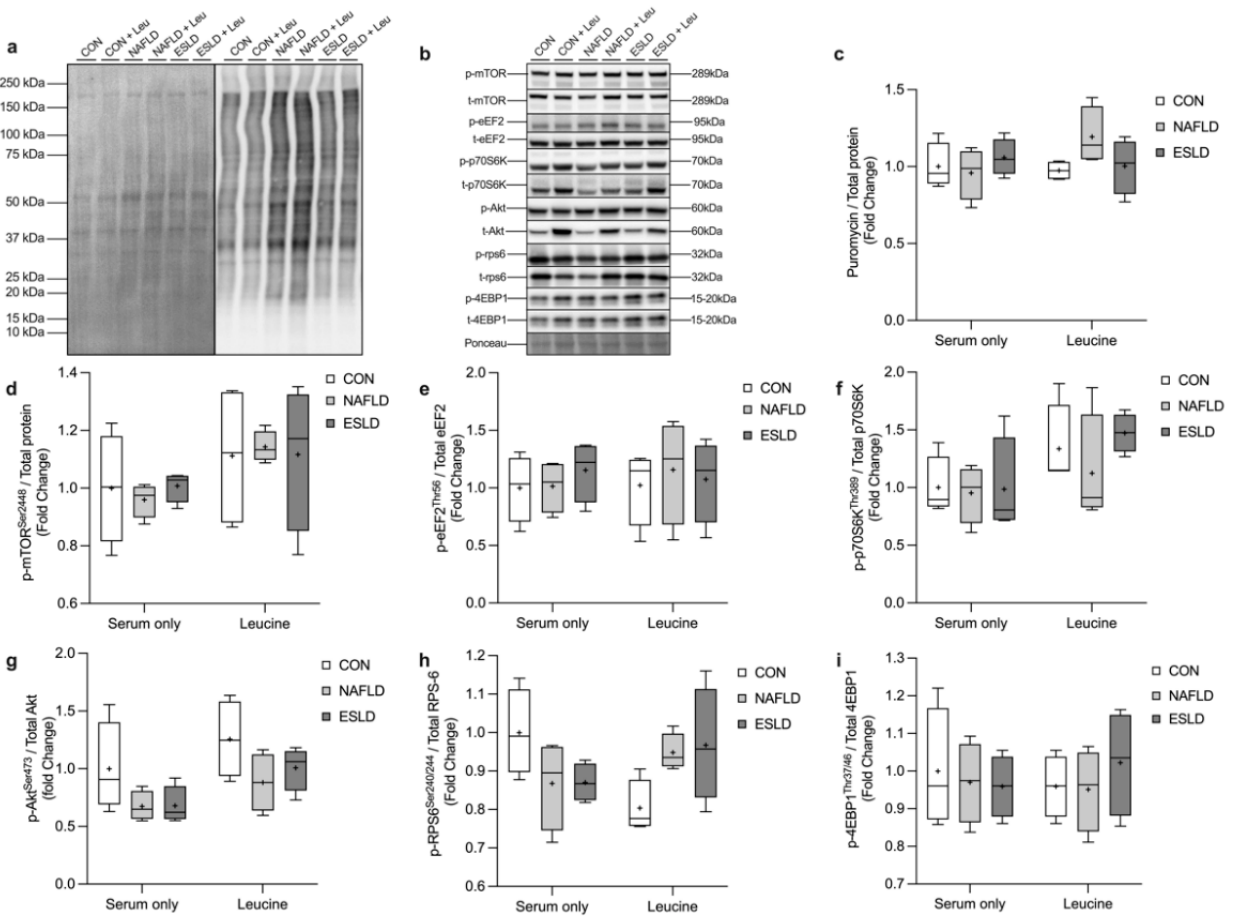
Figure 2. Measures of MPS and anabolic signaling in response to treatment with CON, NAFLD and ESLD serum. Myotubes were treated for 4 h with ex vivo serum from age-matched control (CON), non-alcoholic fatty liver disease (NAFLD) and end stage liver disease (ESLD) patients. ( a ) Representative western blot for puromycin and total protein, ( b ) representative western blots for anabolic signaling targets and loading control, ( c ) puromycin incorporation, ( d ) phospho-mTOR (Ser2448)/total-mTOR, ( e ) phospho-eEF2 (Thr56)/total-eEF2, ( f ) phospho-p70S6K (Thr389)/total- p70S6K, ( g ) phospho-AktSer473/total-Akt, ( h ) phospho-RPS6 (Ser240/244)/total-RPS6, ( i ) phospho- 4EBP-1 (Thr37/46)/total-4EBP-1. Data are expressed as the mean (cross), median (central horizontal line), 25th and 75th percentiles (box) and the minimum and maximum values (vertical lines), with n = 4 per group and each data point corresponding to the average of 3 technical repeats.